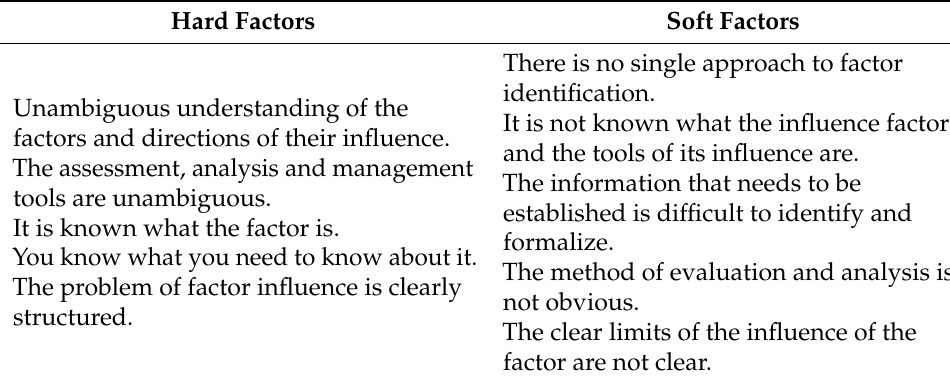
Table 3. Identification of “hard” and “soft”